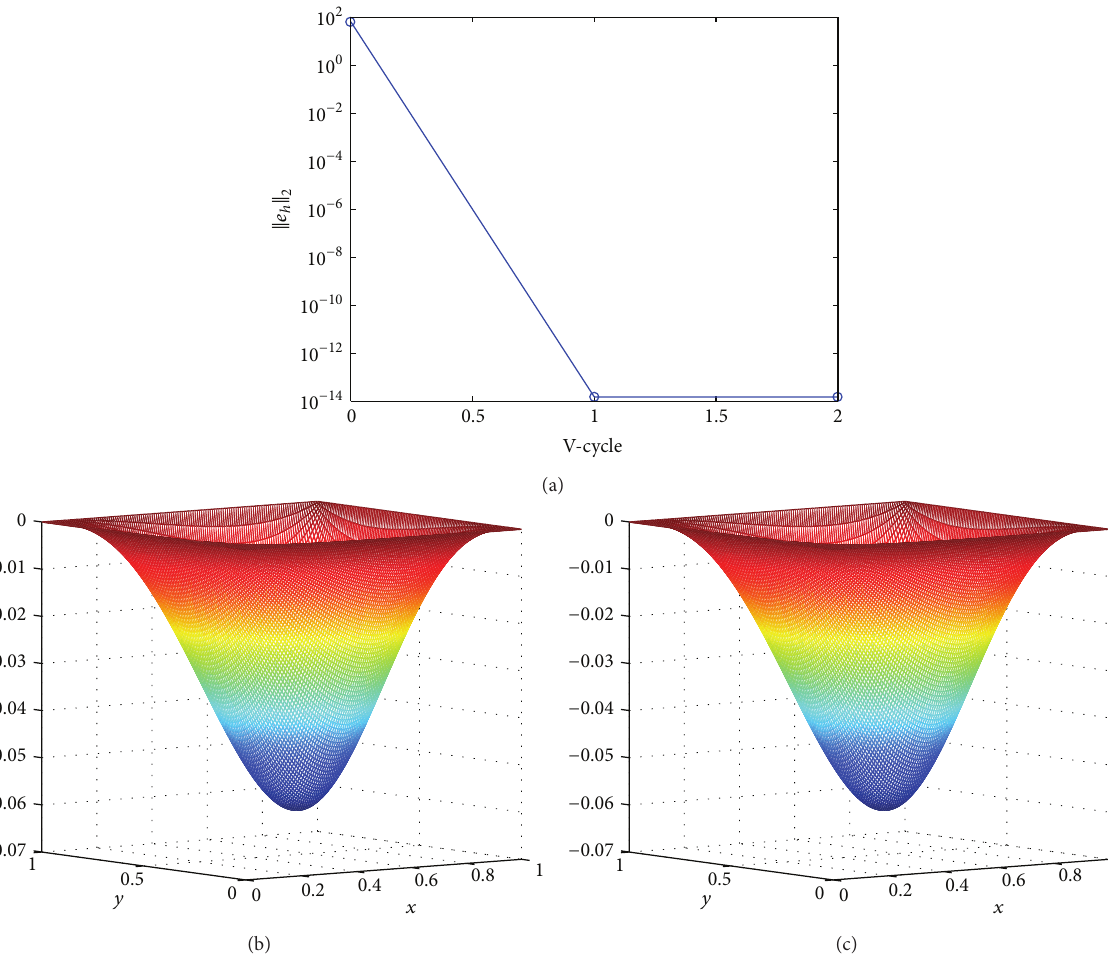
Figure 2: (a) The error graph. (b) Exact solution. (c) The approximation solution. The error vector 𝑒 𝑖𝑗 = 𝑢 𝑖𝑗 − V 𝑖𝑗 and 𝑁 = 128 are the number of nodes and ℓ = 100 for Example